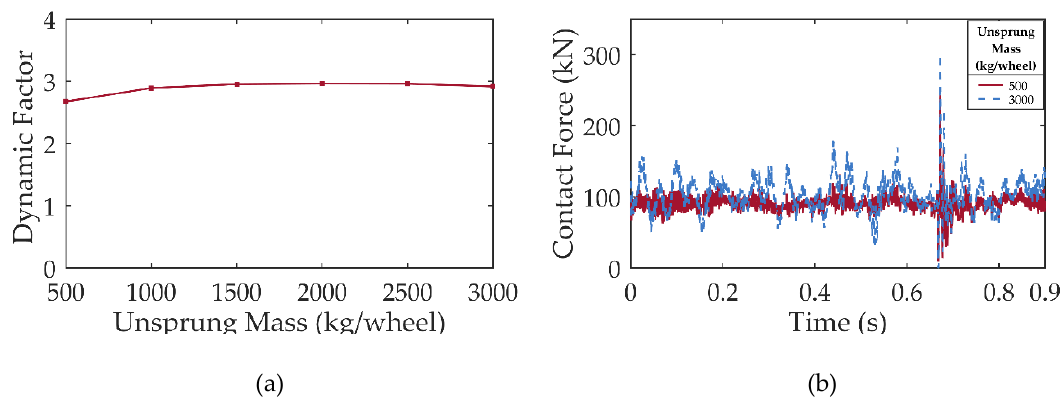
Figure 16. Effect of mass: ( a ) variations in dynamic factor which correspond to different wheel Figure 16. E ff ect of mass: ( a ) variations in dynamic factor which correspond to di ff erent wheel masses; masses; ( b ) contact forces for minimum and maximum modulus of elasticity. ( b ) contact forces for minimum and maximum modulus of elasticity.